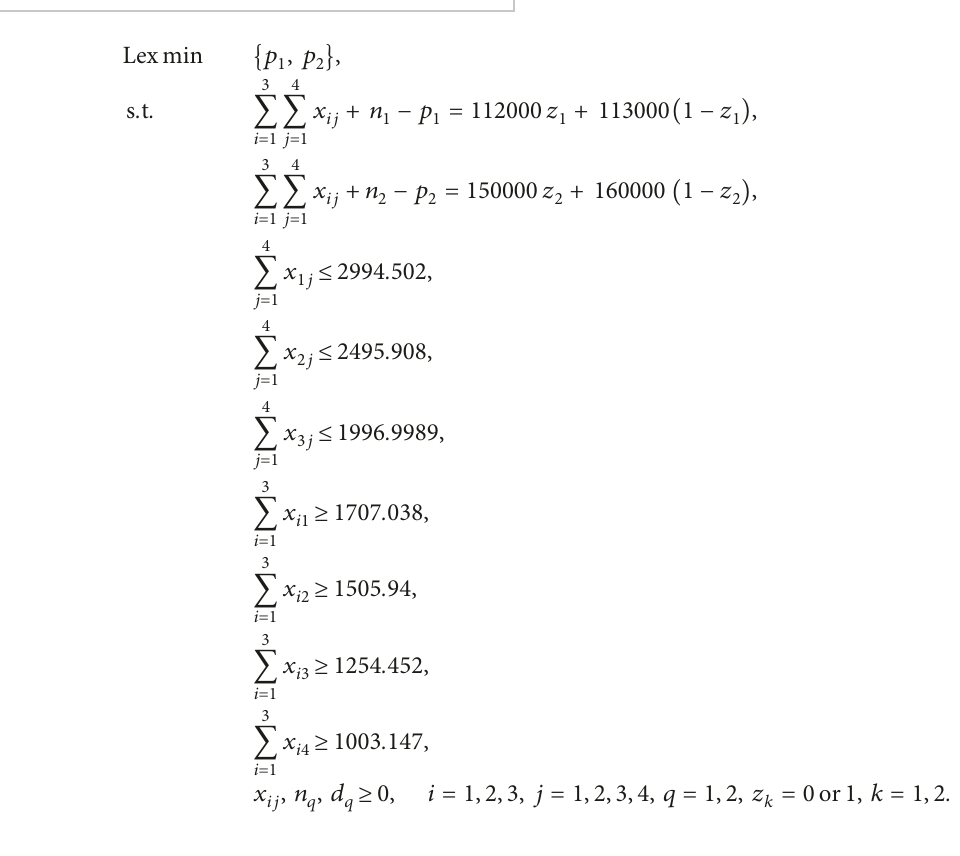
Table 2: Values of location and scale parameter with SPL of a Shape parameter